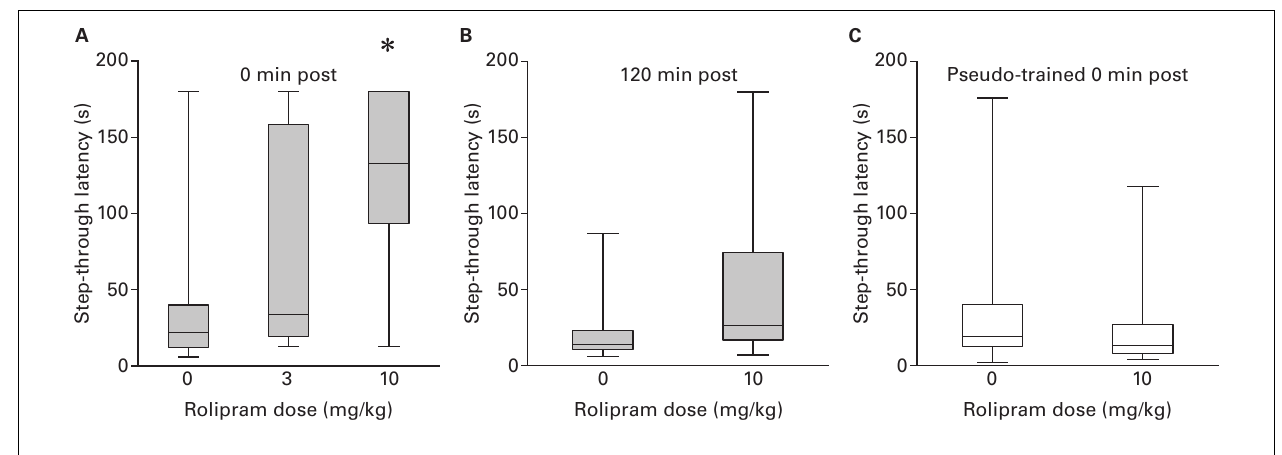
immediately after training with the 0.35 mA foot-shock measured 1 week post-training (*vs all, p < 0.05); (C) Step-through latency (median and inter- quartile range) as a function of Rolipram dose (0 vs 10 mg/kg) injected 120 min after training with the 0.35 mA foot-shock measured 1 week